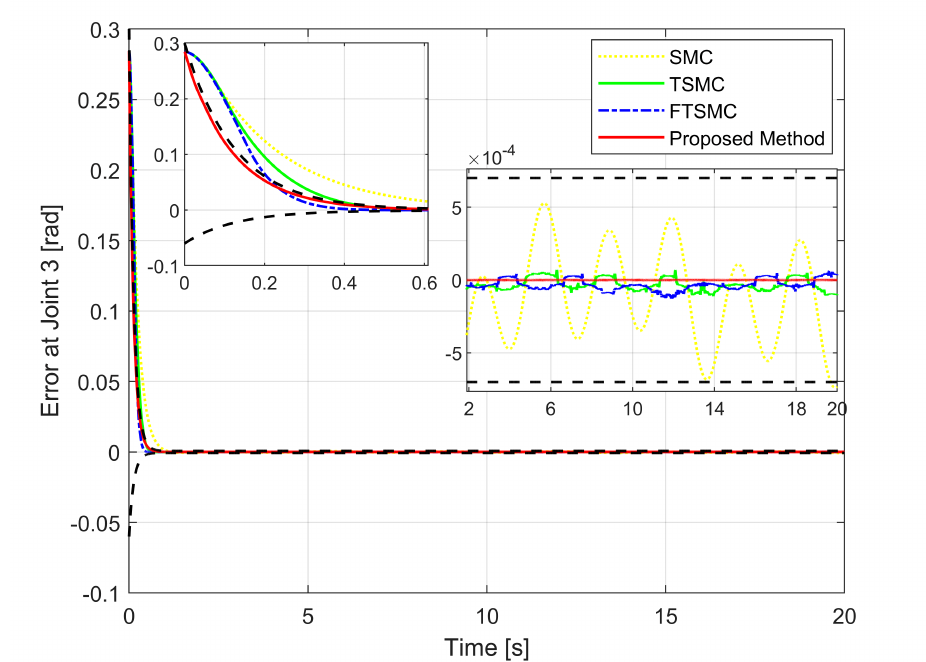
Figure 8. Tracking error of the third joint versus the desired